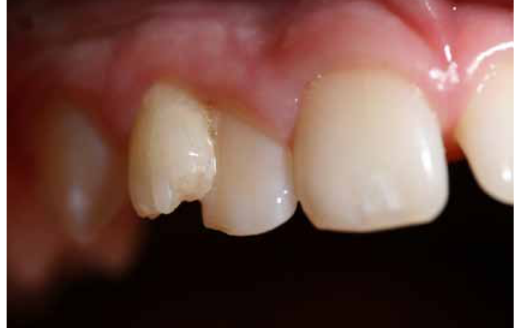
Figure 2. Case 2 (tab.1). Concrescent tooth 12 and supernumer- ary tooth- preoperative view.